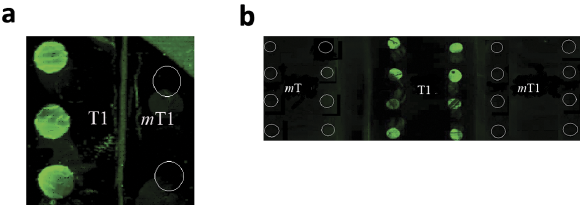
Figure 5. Hybridization on gold surface (a) or glass surface (b). PNA probe P1 was conjugated to the gold or glass surface at circled area. Hybridization was performed with either 50 pmol T1 (perfect match wild type target, green circles), mT (single mismatch on only glass surface, black circles,or m T1 (two bases mismatch, black circles) DNA targets tagged with FITC. Image was acquired after washing the targets off the surface.